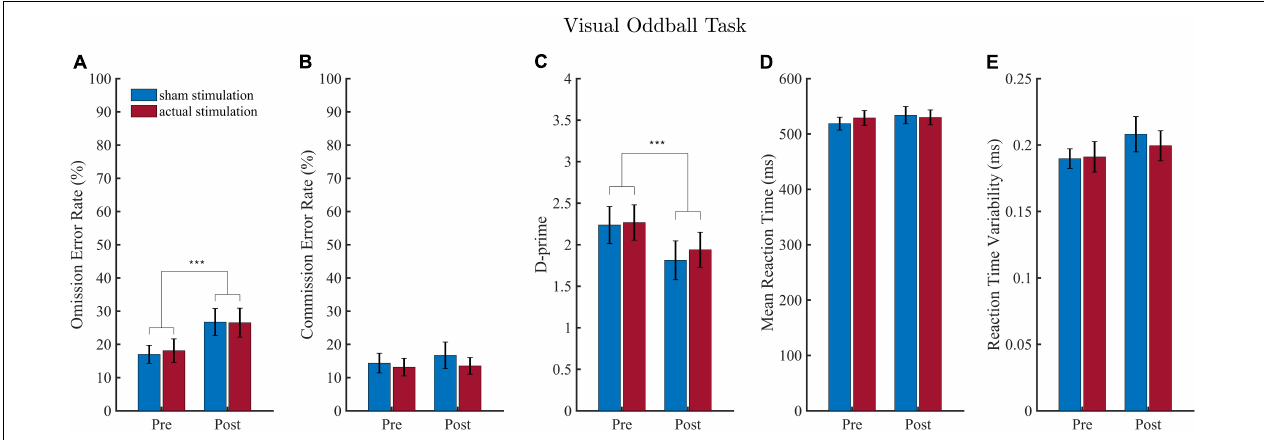
FIGURE 3 | Results of the visual oddball task (VOT). Error rates are depicted in (A,B) and the sensitivity measure D-prime in (C) . Results of the mean reaction time (RT) and reaction time variability (RTV) are illustrated in (D,E) . Values depict means and SEMs for the sham stimulation (blue bars) and actual stimulation (red bars) before and after actual or sham stimulation. ***p < 0.001.